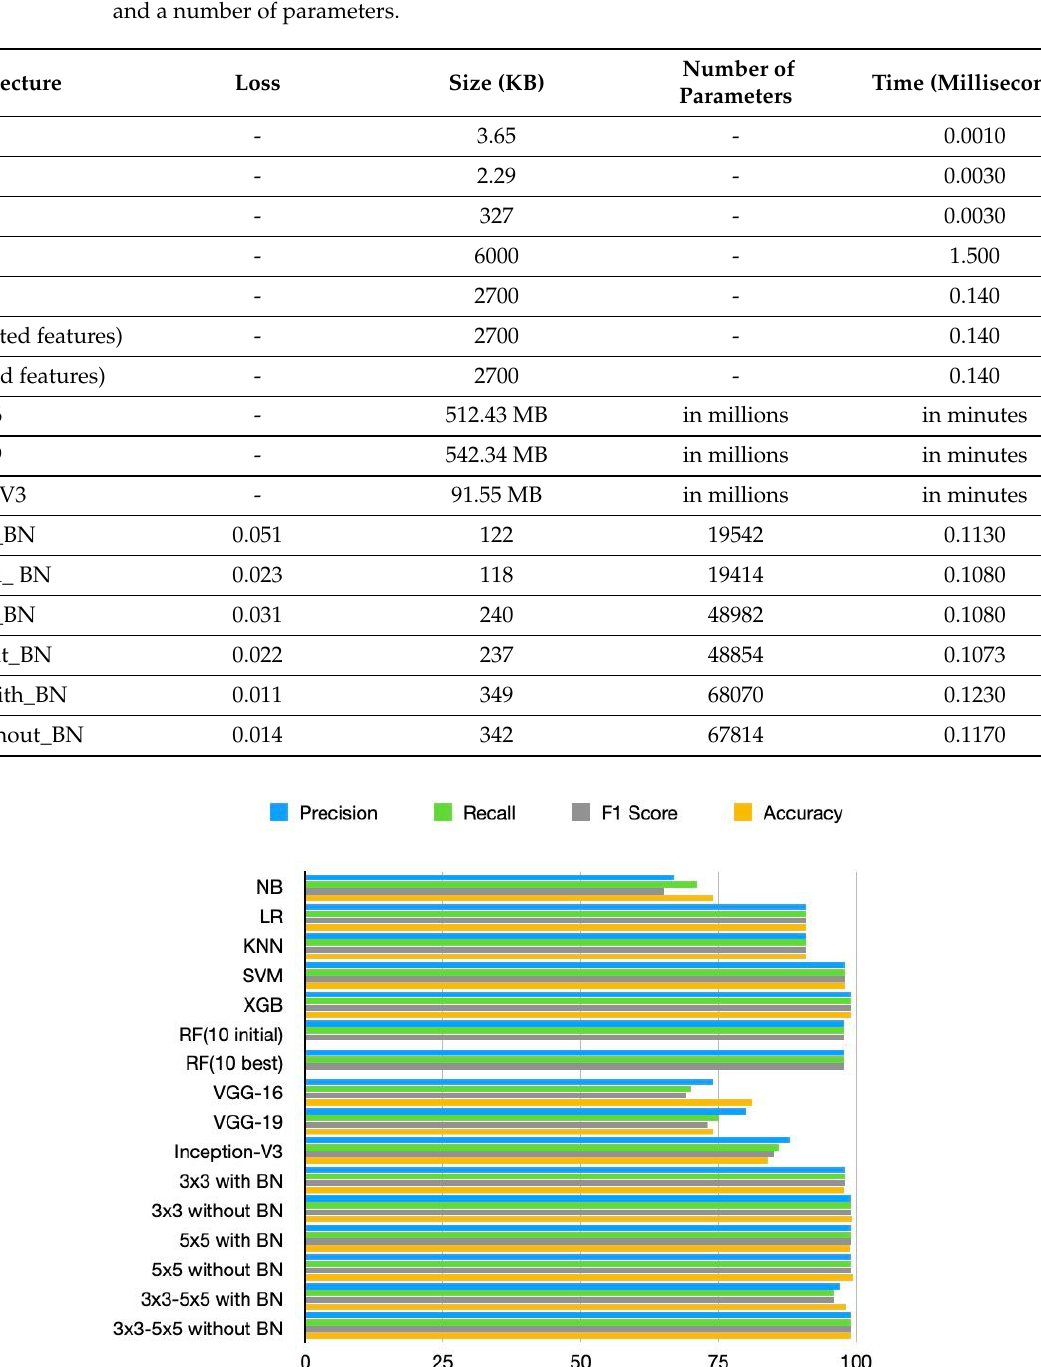
Table 6. Comparison of the proposed approach with previous works in terms of size, running time, and a number of parameters.